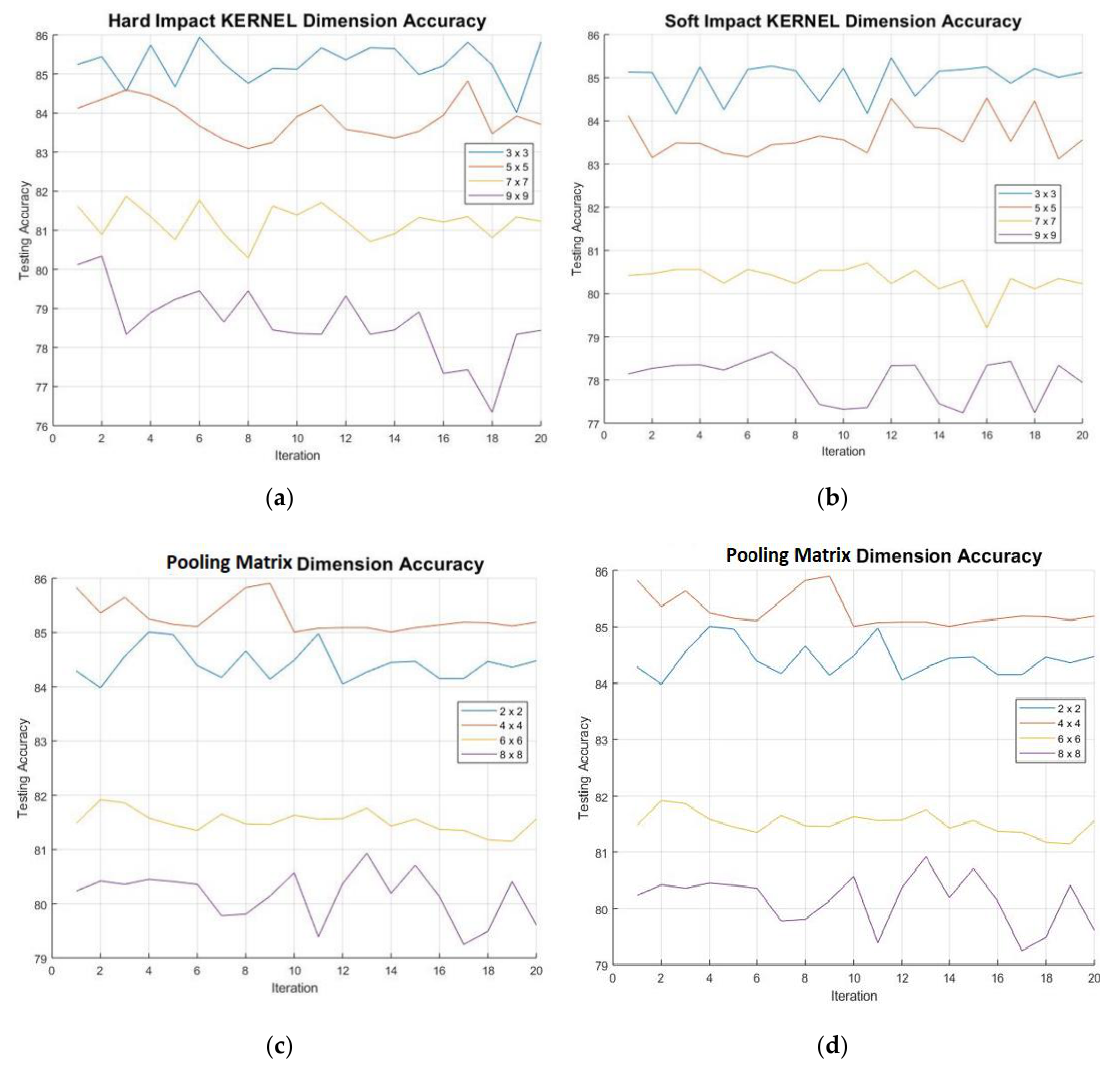
Figure 14. ( a , b ) indicate percentage accuracy of HI Kernel and Pooling dimensions respectively; ( c , d ) indicate percentage accuracy of SI Kernel and Pooling dimensions respectively.